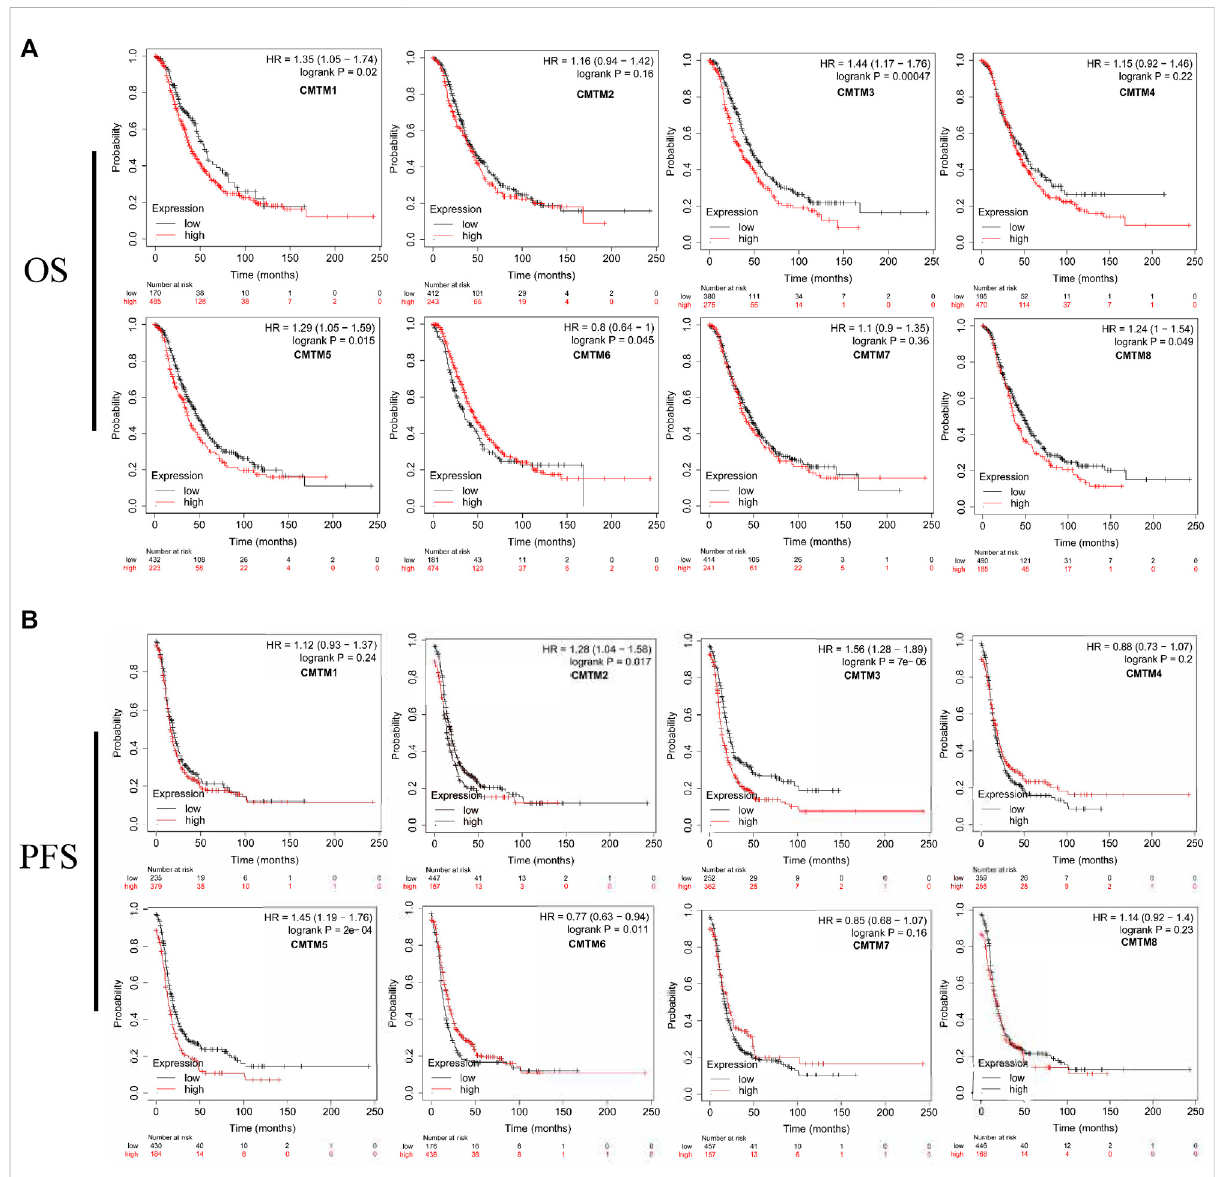
FIGURE 5 Survivalanalysisofovarian cancer patientswith highand lowmRNA expression levels ofdifferentCMTM family members. (A) The survival curve of the overall survival time of the high gene expression group and the low gene expression group. (B) The survival curve of the progression-free survival of the high gene expression group and the low gene expression group. The logrank p value, HR (hazard ratio), and 95% con fi dence interval were recorded. p value of < 0.05 was considered statistically signi fi